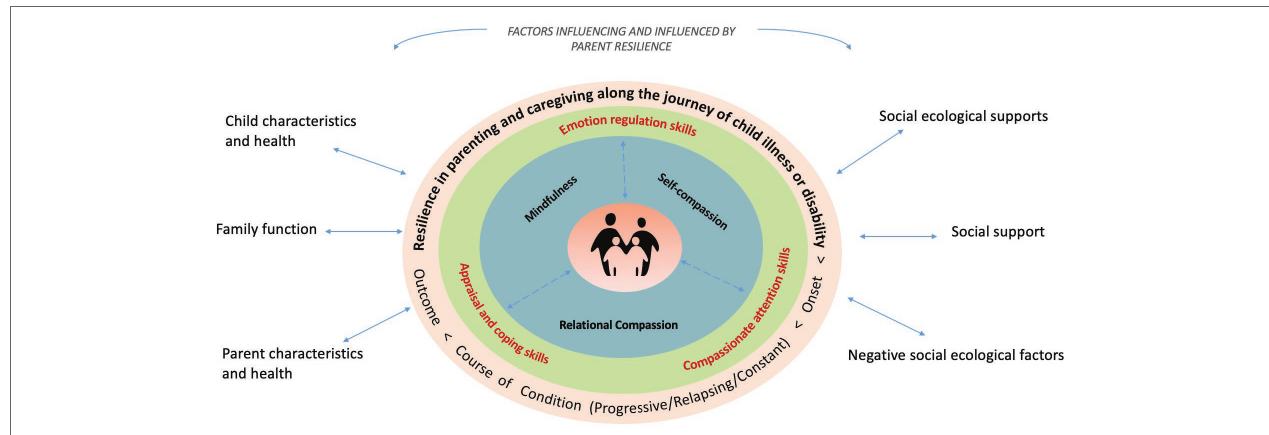
FIGURE 1 | Model of Compassion, Mindfulness and Resilience in Parental Caregiving. The model places the parents in the center, as the source of their own well-being. The blue ring shows the three core areas of skill development in CMBIs. Developing these skills can enable the parent to cultivate three capacities in the green ring – appraisal and coping, emotion regulation, and compassionate attention – which are essential when parenting a child with a chronic condition. There is a bidirectional relationship between these inner resources and the trajectory of a chronic condition (orange ring) because the parent’s resilience can be challenged or further developed in response to changing circumstances surrounding the child’s health and care needs and other contextual factors (outside the